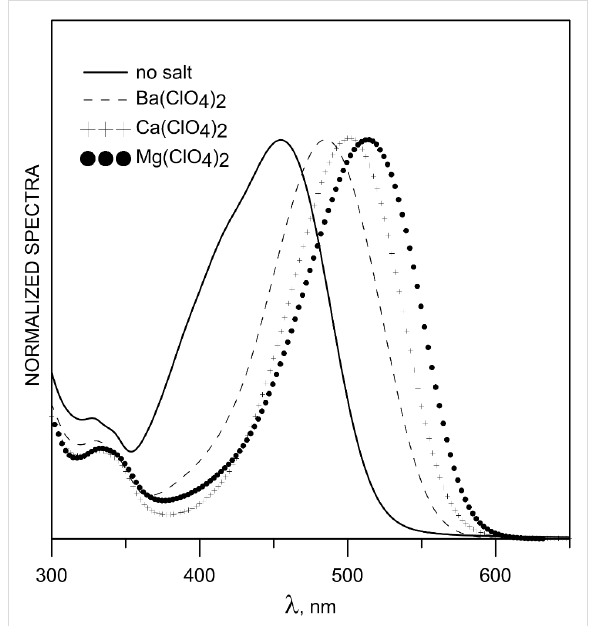
Figure 5: Normalized spectra of the free ligand 6 ( c = 5 × 10 − 5 M) and its complexes obtained with Ba(ClO 4 ) 2 , Ca(ClO 4 ) 2 and Mg(ClO 4 ) 2